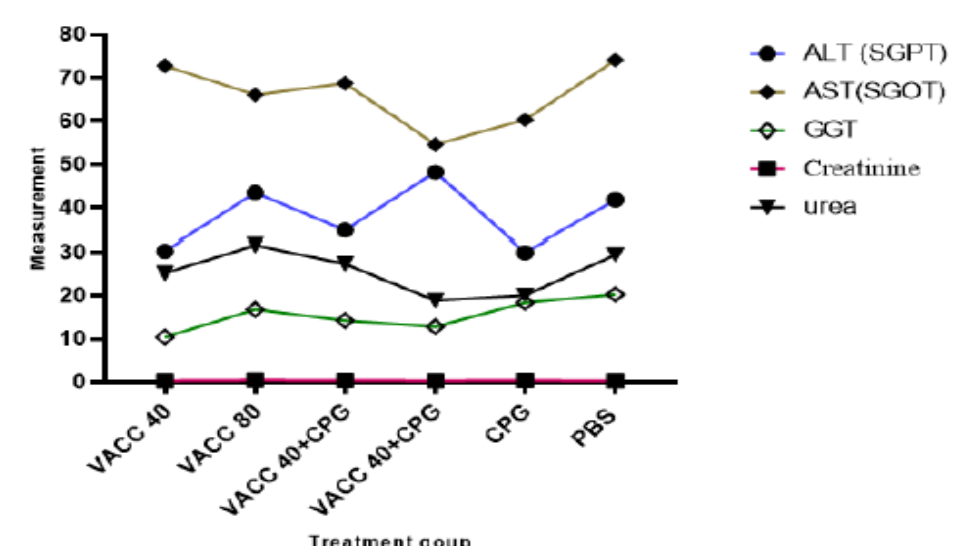
Figure 5. Results of biochemical analysis. VACC 40 and VACC 80: groups treated with 4 × 10 9 VP and 8 × 10 9 VP of vaccine concentration, respectively, VACC 40 +CpG and VACC 80 + CpG: groups treated with 4 × 10 9 VP and 8 × 10 9 VP of vaccine plus CpG ODNs, CpG: group treated with CpG ODNs and PBS: group treated with PBS.